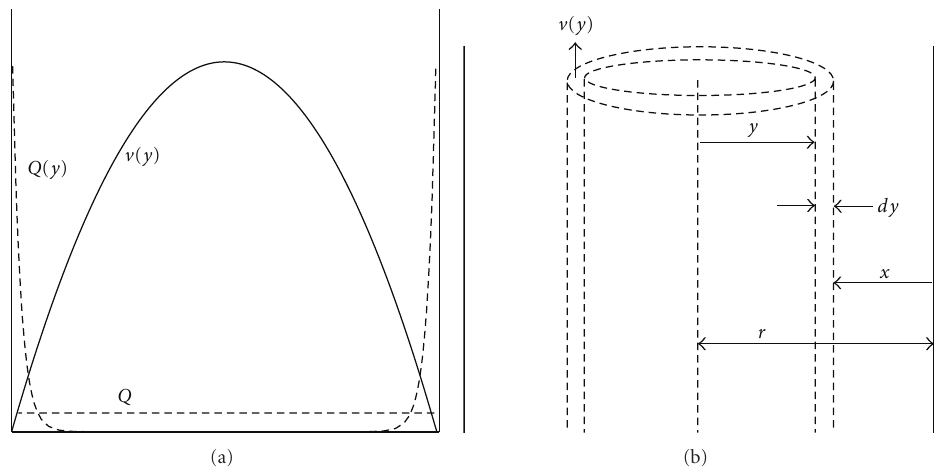
Figure 1: (a) Flow velocity (solid line) and excess countecharge within a capillary, invoking the “thin” (short dashes) and “thick” (long dashes) double-layer assumption and assuming a constant excess surface charge density. The width of the “thin” double-layer has been greatly exaggerated. The excess charge on the capillary surface, and hence the total excess countercharge within the capillary, are the same for both the “thin” and “thick” double layer assumptions; the only di ff erence between the models is the distribution of the countercharge within the capillary. (b) Calculation of the streaming current. Assuming Poiseuille flow, each cylinder of fluid of thickness dy travels at velocity v ( y ) and transports an excess charge density Q ( y ). The distribution of excess charge within the capillary impacts on the streaming current because excess charge at the centre of the capillary is transported more rapidly by the flow than excess charge at the margin of the capillary. Modified from Jackson